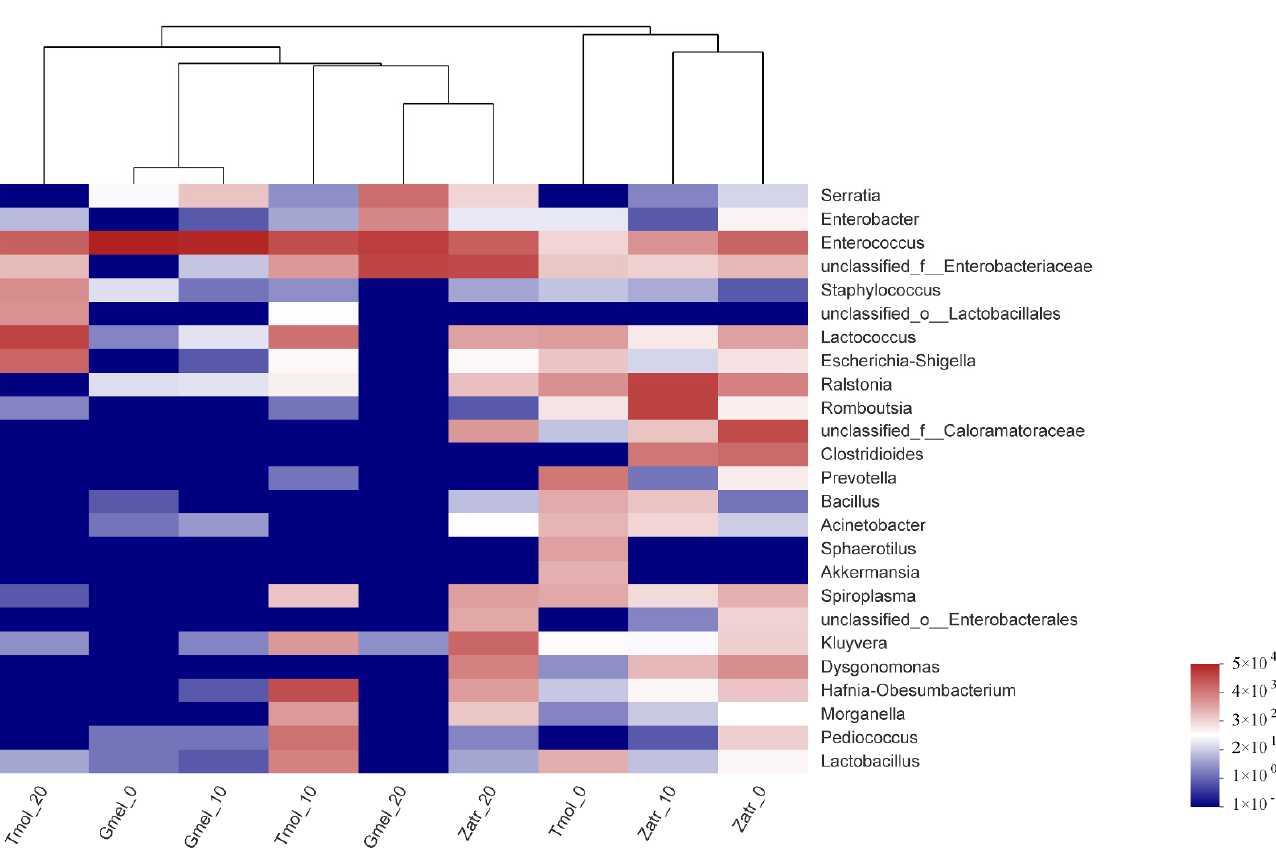
Figure 5. Gut bacterial community heatmap analysis of nine samples of the three species’ larvae. The analysis is on the basis of the top 25 abundant genera. The color intensity of the scale indicates the relative abundance. Tmol: yellow mealworm, Gmel: greater wax moth, Zatr: superworm.